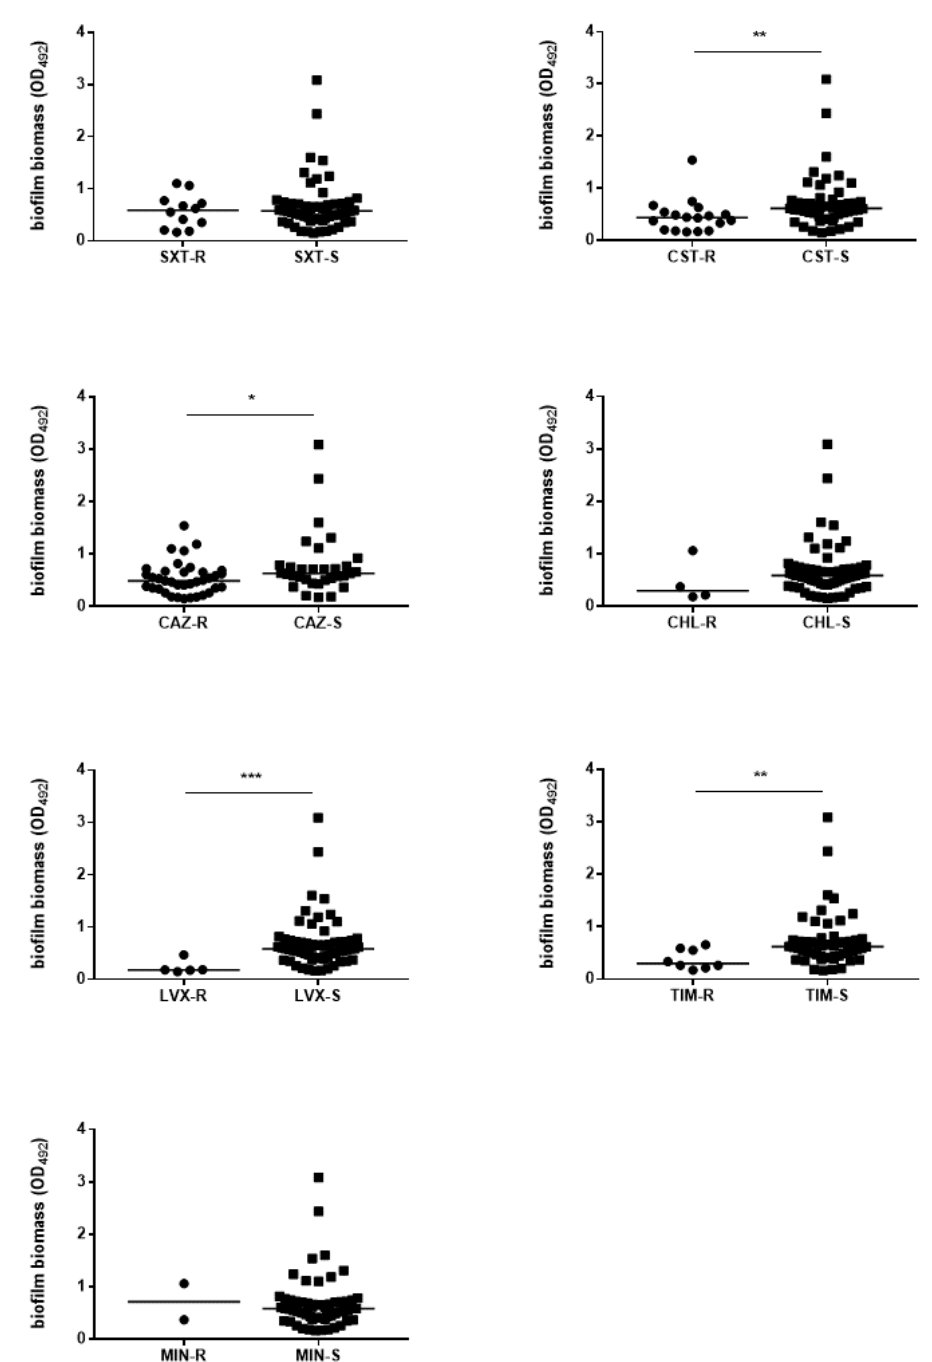
Figure 7. Biofilm formation by S. maltophilia pathogenic strains: stratification on the susceptibility phenotype. Pathogenic strains—defined according to the CDC guidelines [22]—were tested for biofilm formation in a 96-well polystyrene microtiter plate by crystal violet assay after a 24 h-incubation at 37 ◦ C. Results were stratified on the resistance (R) or susceptibility (S) to each antibiotic tested (SXT, trimethoprim-sulfamethoxazole; CST, colistin; CAZ, ceftazidime; CHL, chloramphenicol; LVX, levofloxacin; TIM, ticarcillin-clavulanic acid; MIN, minocycline) evaluated by the disk diffusion technique. Each dot shows the mean OD 492 value, with the horizontal line indicating the median value of each distribution. * p < 0.05, ** p < 0.01, *** p < 0.001, Kruskal-Wallis test followed by a Dunn’s multiple comparison post-test.